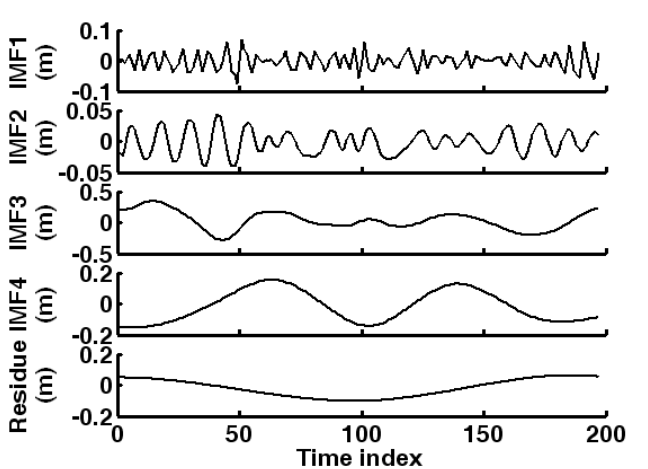
Figure 4. Decomposition results for the time series after